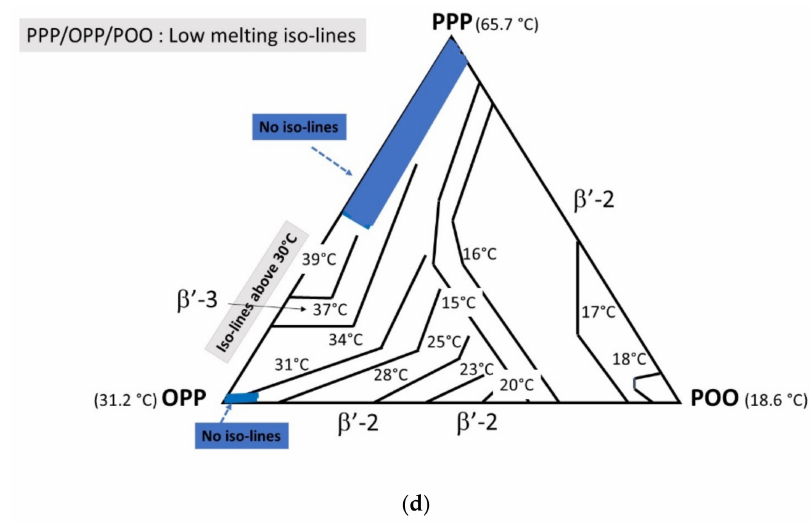
Figure 6. ( a ) (PPP / POP / POO) phase diagram high melting iso-lines; ( b ) (PPP / POP / POO) phase diagram low melting iso-lines; ( c ) (PPP / OPP / POO) phase diagram high melting iso-lines and ( d ) (PPP / OPP / POO) phase diagram low melting iso-lines, in direct